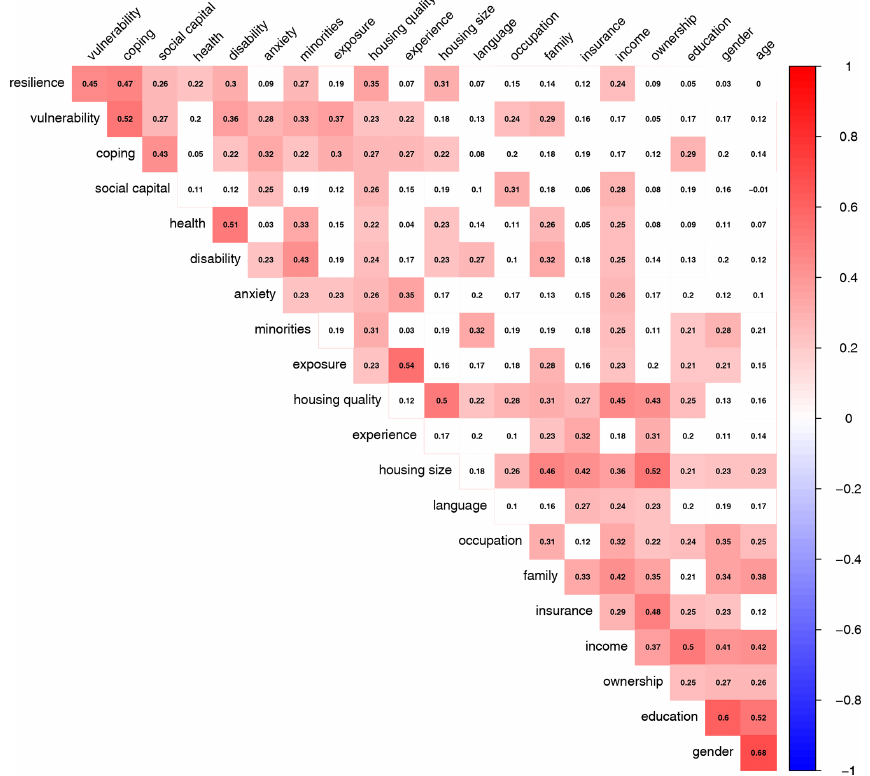
Figure 9. Heatmap of the correlations among the variables used to explain risk perception and behaviour.